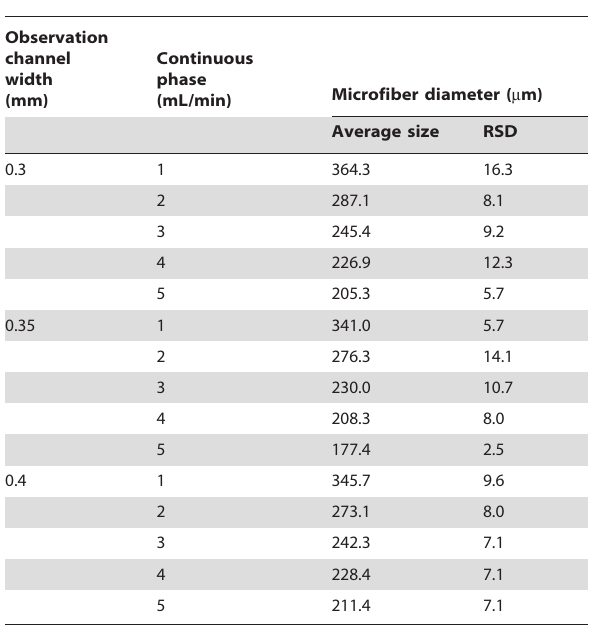
Table 1. The relationships among the diameter of microfibers, width of observation channel and flow rate of continuous phase.